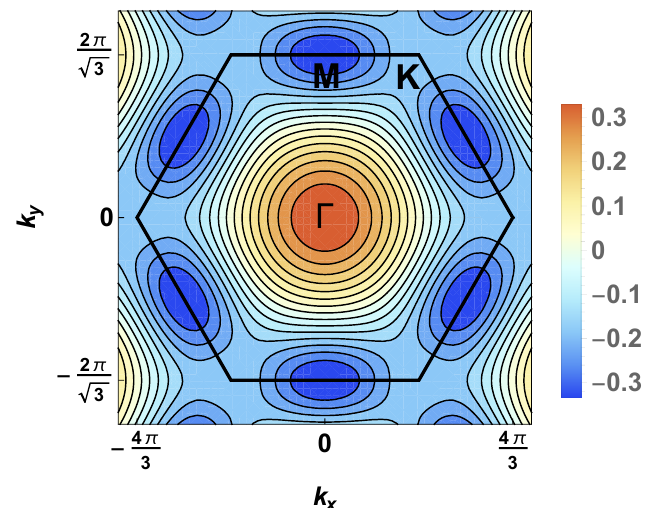
Figure 5: Plot of the perturbative result for the fermion dispersion relation (cid:34) ( k ) from = − Eq. (20) for δ t 1